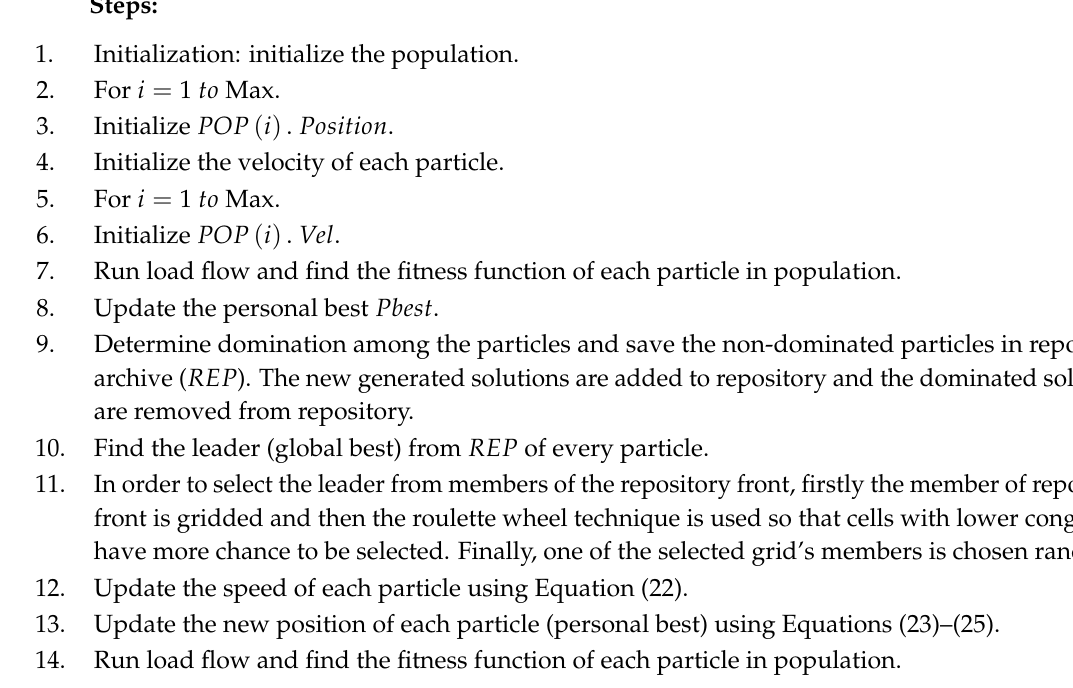
Figure 3. Flow chart for optimal DG configuration using proposed method.